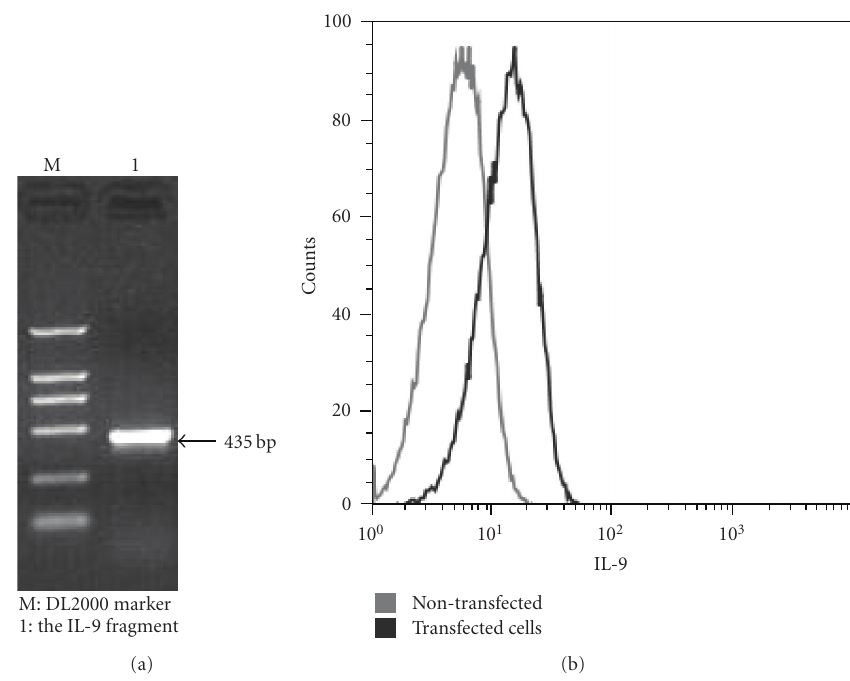
Figure 1: Cloning and expression of IL-9. (a) The coding sequence for mouse IL-9 was obtained from mRNA isolated from spleens. (b) BHK cells 48 h after the transfections with proV-IL9 and untransfected were collected, fixed, and intracellularly stained with anti-IL-9-PE. The results were analyzed by the FACScalibur.